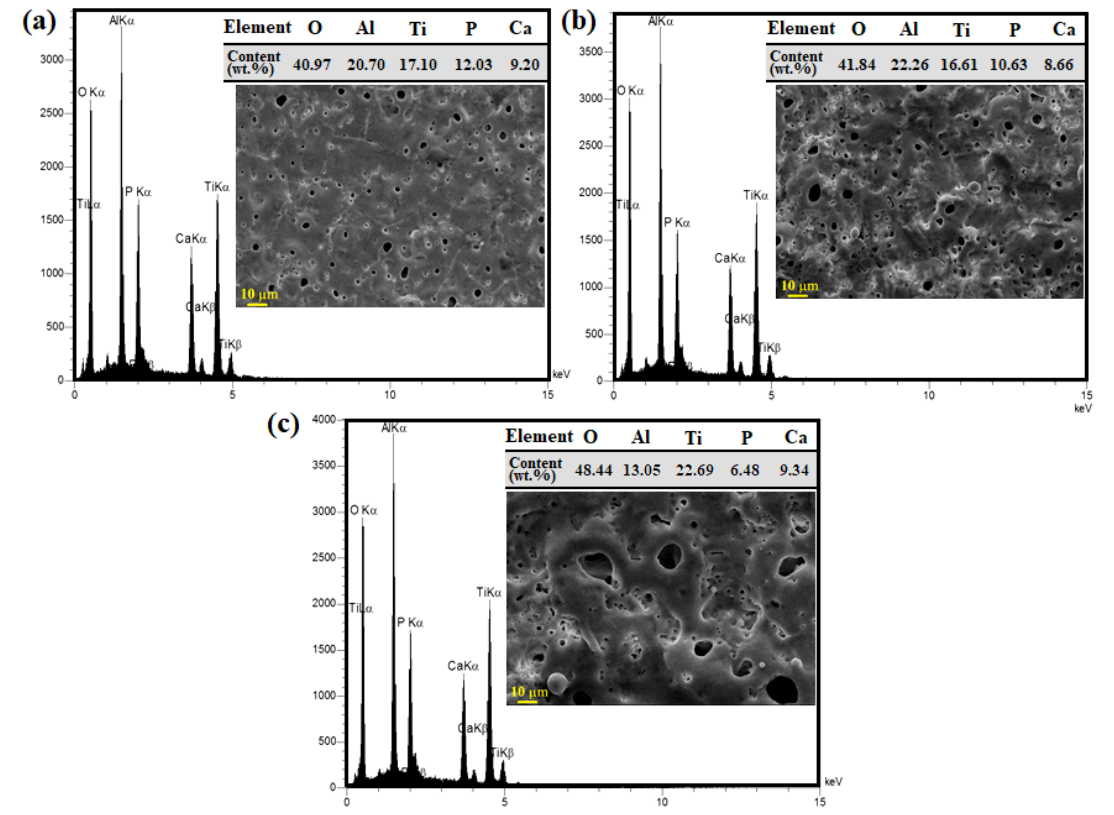
Figure 3. EDS spectra and SEM micrographs for PEO coating samples prepared under applied voltages of ( a ) 400 V, ( b ) 450 V, and ( c ) 500 V. voltages of ( a ) 400 V, ( b ) 450 V, and ( c ) 500